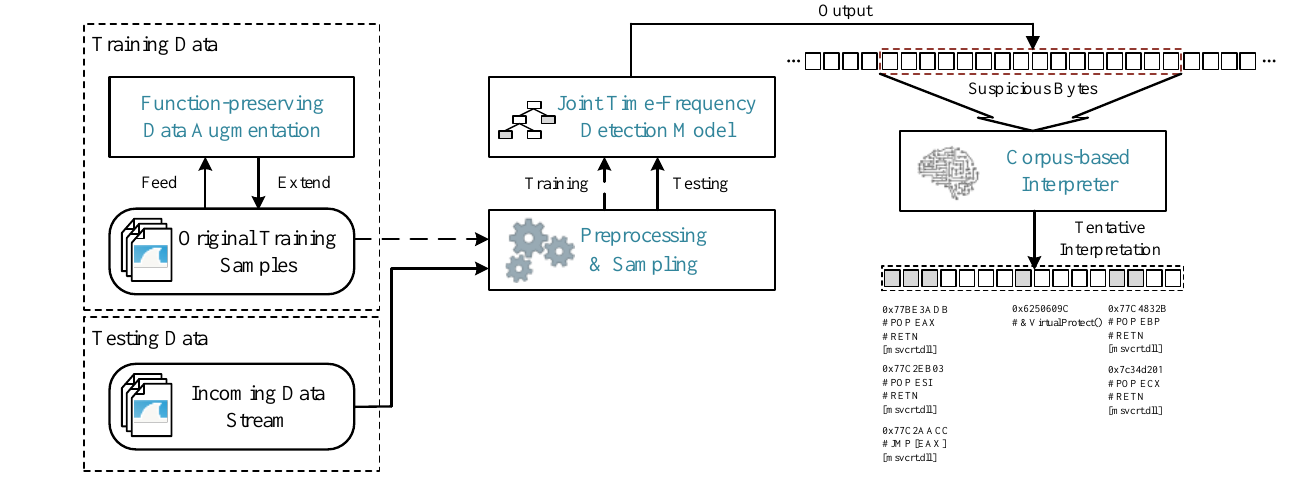
Figure 2. An overview of Horus framework.